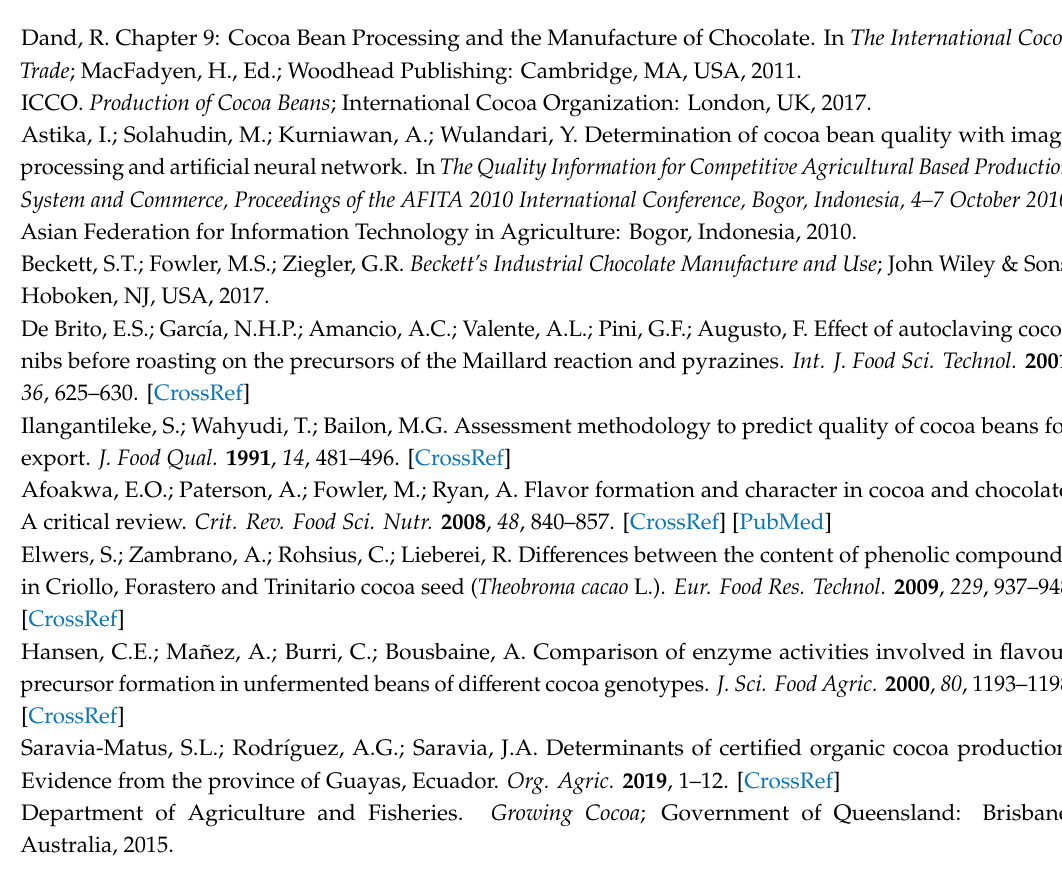
Figure S1. Map showing the site location where the study was conducted. The image was obtained from Google Earth (Google Technology company, Menlo Park, CA, USA); Figure S2. Diagram representing the methods used in the study, where (A) represents the canopy architecture assessment at ground level using the VitiCanopy app, (B) depicts the cacao pods processing and assessment of volatile compounds using gas chromatography, mass spectroscopy, (C) the development of the machine learning modelling using (A) as inputs and (B) as targets / outputs, (D) represents the canopy architecture assessment from aerial images using a customized Matlab ® code, and (E) the development of spatial distribution maps using the outputs from (C) using the data from (D) as inputs; Figure S3. Peak areas of the six volatile compounds found in the fermented cocoa bean samples used to develop the machine learning model. All values are reported in scientific notation 10 3 . Sample codes: B1 = Block 1, B2 = Block 2, C# = number of the tree, and A or B = position of the tree